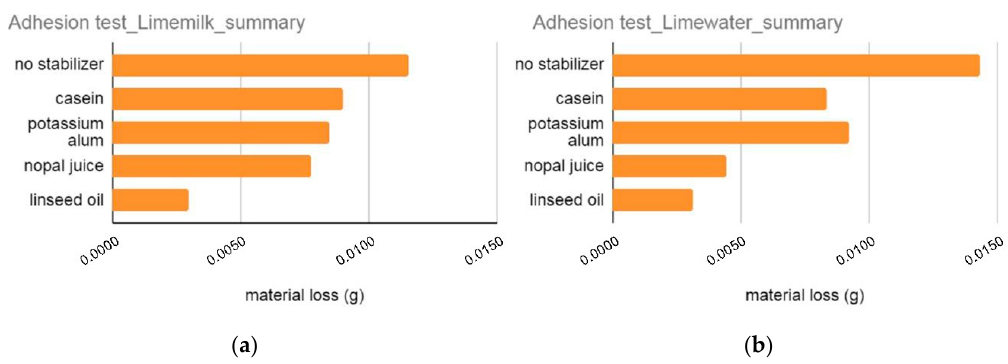
Figure 18. Summary of results for adhesion test for ( a ) Limemilk and ( b ) Limewater without stabilizer and with four natural stabilizers.